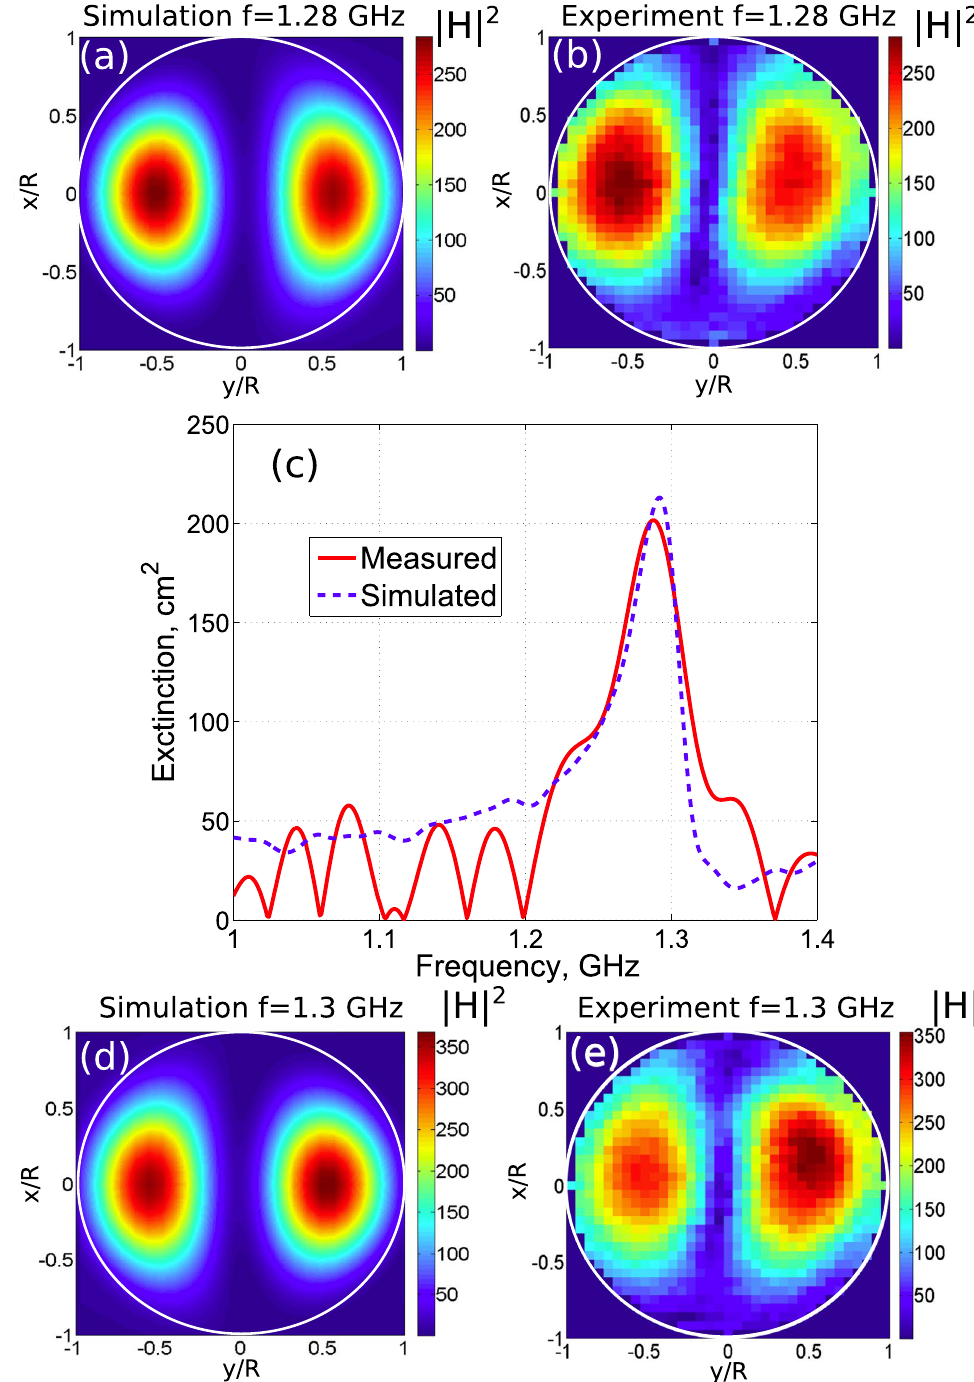
Figure 2. Numerically simulated and experimentally measured magnetic field distributions in the cylinder cross section placed at the 3 cm distance from its top surface at the frequency ( a , b ) 1.28 GHz and ( d , e ) 1.3 GHz for the TE polarized plane wave excitation. The magnetic field is normalized over the incident wave component H 0 . ( c ) Measured and simulated extinction cross sections of the cylinder, which is filled with distilled water at temperature 90 °C. The incident plane wave propagates along the y -axis. The axis of the cylinder is parallel to the z